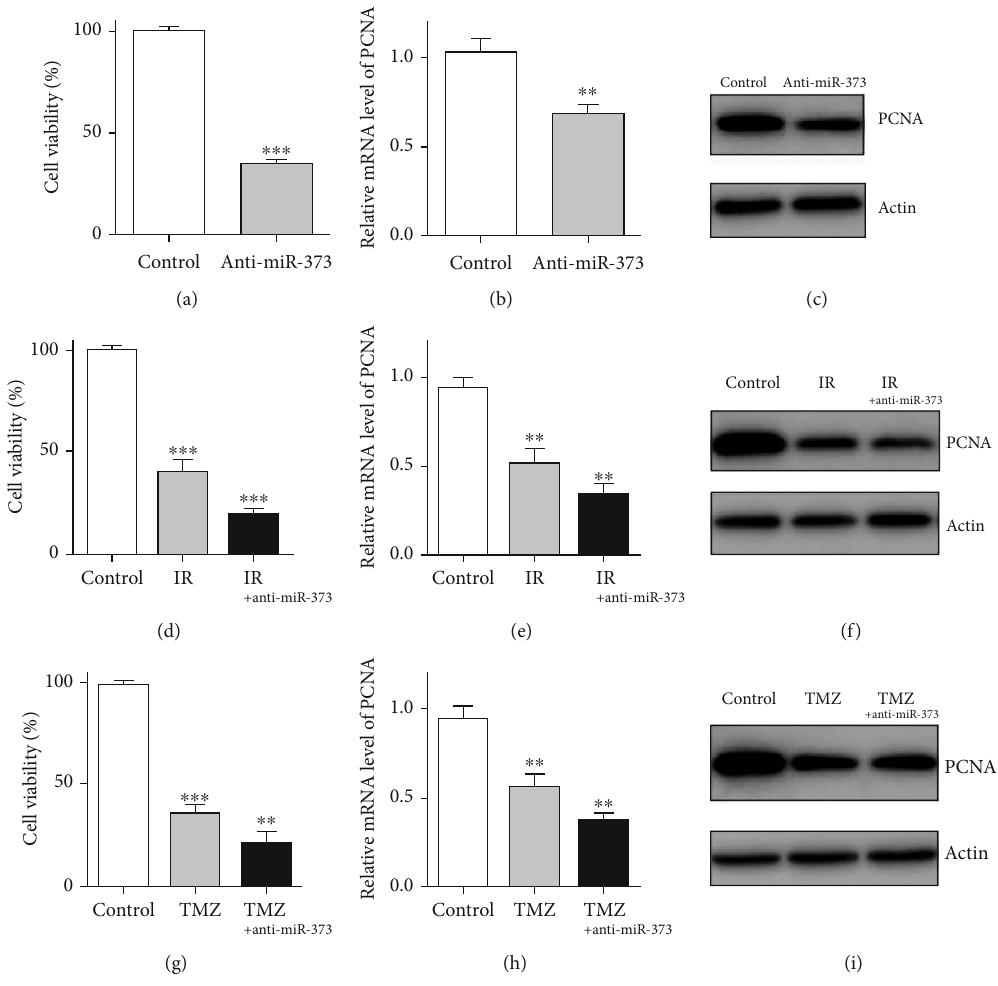
Figure 2: Inhibition of miR-373 reduced the U-251 cell proliferation. (a) Anti-miR-373 could reduce the U-251 cell proliferation by MTT assay. (b) PCNA mRNA level was also reduced after anti-miR-373 transfection by real-time quantitative PCR in U-251 cells. (c) Western blot results proved the lower expression of PCNA protein after anti-miR-373 transfection in U-251 cells. (d) After ionizing radiation (IR), the cell number of U-251 cells was reduced obviously by MTT assay, and additional e ff ects were also obtained in the group of IR combined with anti-miR-373 transfection. (e) IR could also reduce the PCNA mRNA level in U-251 cells, and such inhibition was enhanced after being combined with anti-miR-373 transfection. (f) PCNA protein expression was also reduced signi fi cantly after ionizing radiation in the presence or absence of anti-miR-373 transfection. (g) After TMZ treatment, the cell number of U-251 cells was reduced obviously by MTT assay, and additional e ff ects were also obtained in the group of TMZ treatment in the presence of anti- miR-373 transfection. (h) TMZ could also reduce the PCNA mRNA level in U-251 cells, and such inhibition was enhanced after being combined with anti-miR-373 transfection. (i) PCNA protein expression was also reduced signi fi cantly after TMZ treatment in the presence or absence of anti-miR-373 transfection (bars indicate the standard deviation of the mean; each experiment was performed in triplicate; ∗∗∗ p < 0 : 001 ; ∗∗ p < 0 : 01